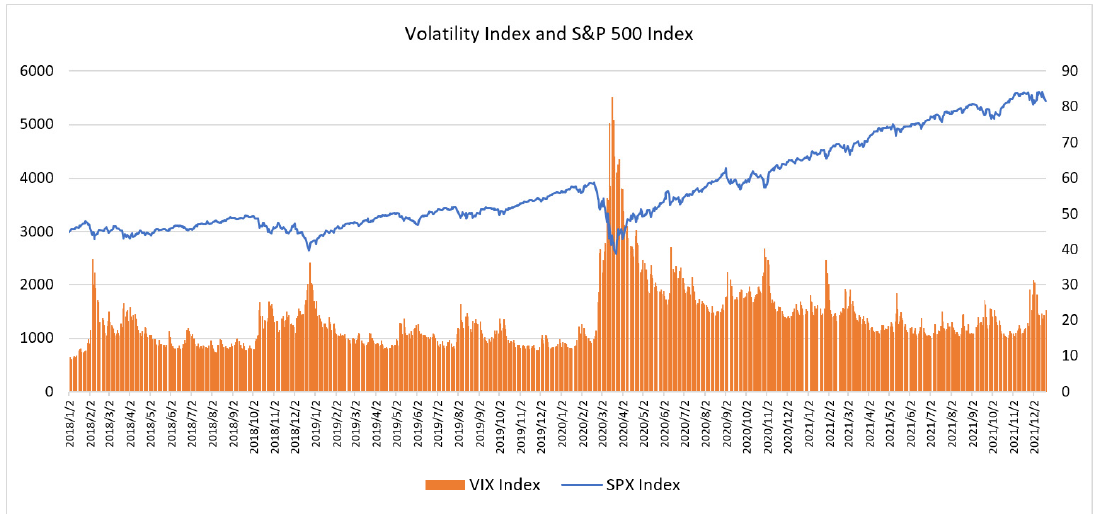
Figure 1. Uncertainty and stock market performance from 2018 to 2020. Source: Authors’ illustration based on data from Bloomberg. Note: VIX Index is the Chicago Board Options Exchange Volatility Index. SPX Index is the S&P 500